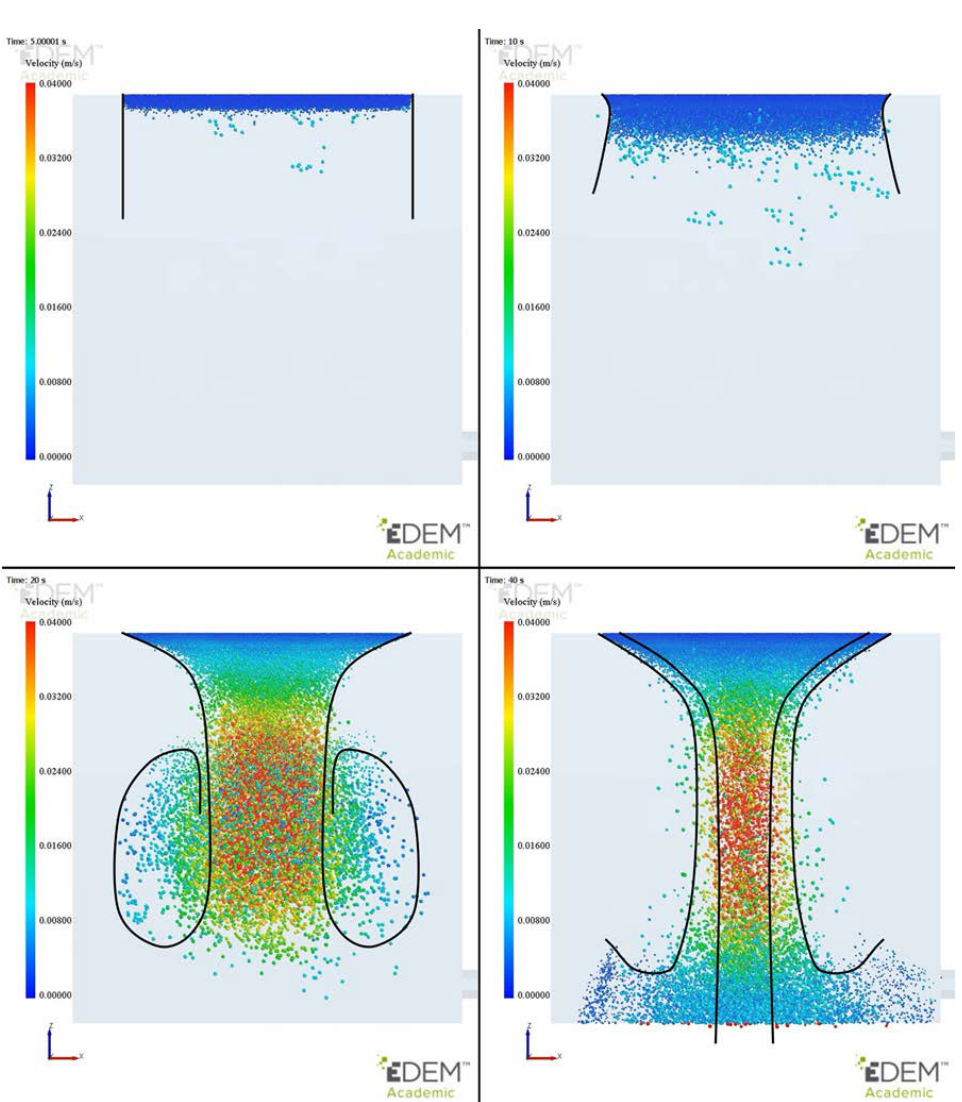
Figure 6. Formation of the funneling effect in the slag at 5 s, 10 s, 20 s, and 40 s.